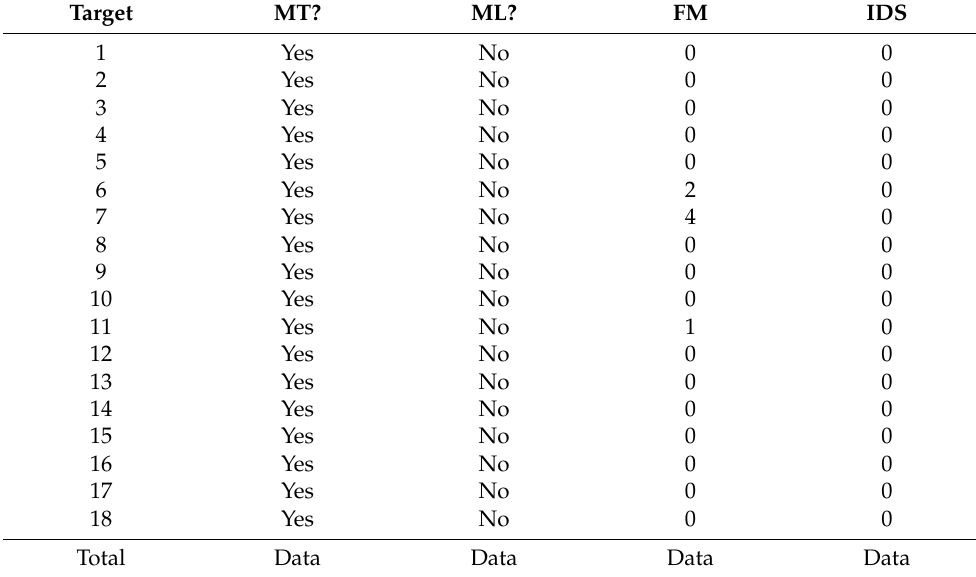
Table 3. Statistical tracking results for each target in the test set.